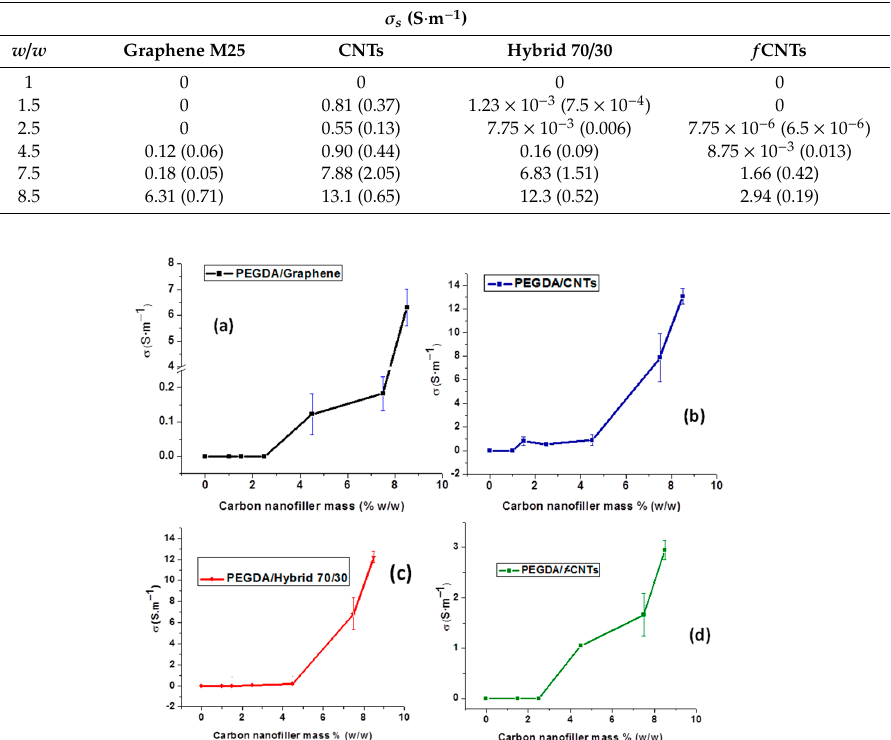
Table 2. The σ s of PEGDA/carbon nanofiller composites in various carbon nanofiller percentage.